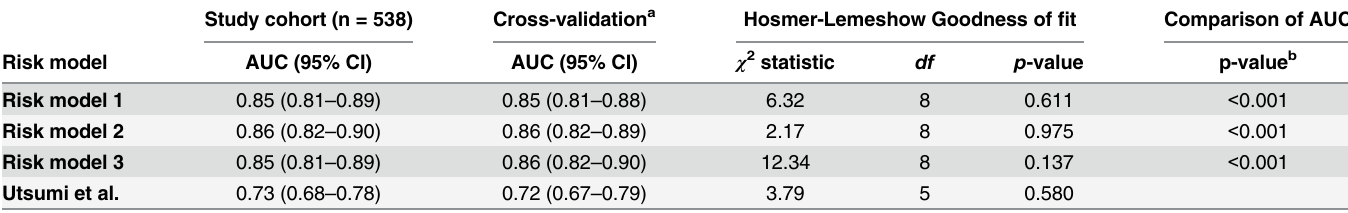
AUC = area under the receiver operating characteristic curve; CI = con fi dence interval. a The performance of each risk scoring model was evaluated by 10-fold cross-validation with an equal number of mutually exclusive ten subgroups of our cohort. b P-values were obtained by DeLong ’ s method of comparing AUC in study cohort between a given model and the reference model (reference model: risk model of Utsumi et